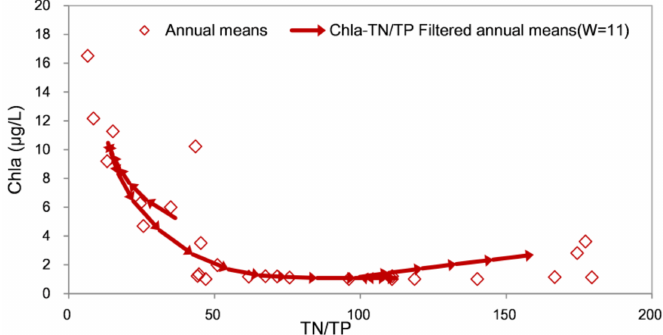
Figure 6. Filtering trajectory diagram of Chl a -TN/TP in the Chaihe Reservoir (1996–2021). The arrow denotes the time direction, where one arrow denotes 1 year. The arrow end represents the data of the year i, and the arrowhead represents the data of the year i+1. W is the number of years in the filtering window.